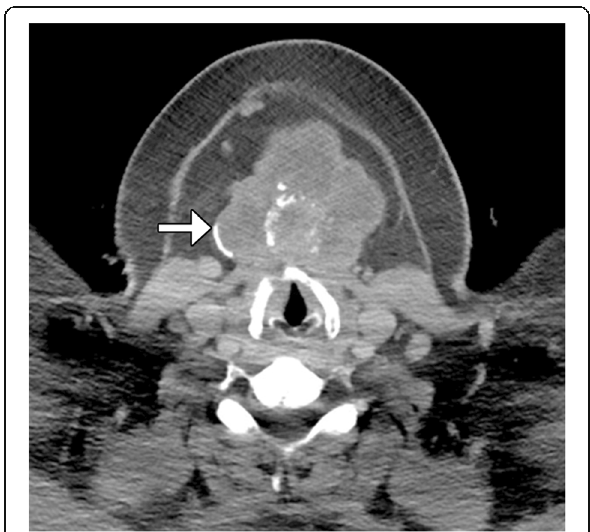
Fig. 14 Papillary thyroid carcinoma arising from thyroglossal duct cyst. Axial CT image shows a bulky cystic and partly calcified mass in the midline anterior neck